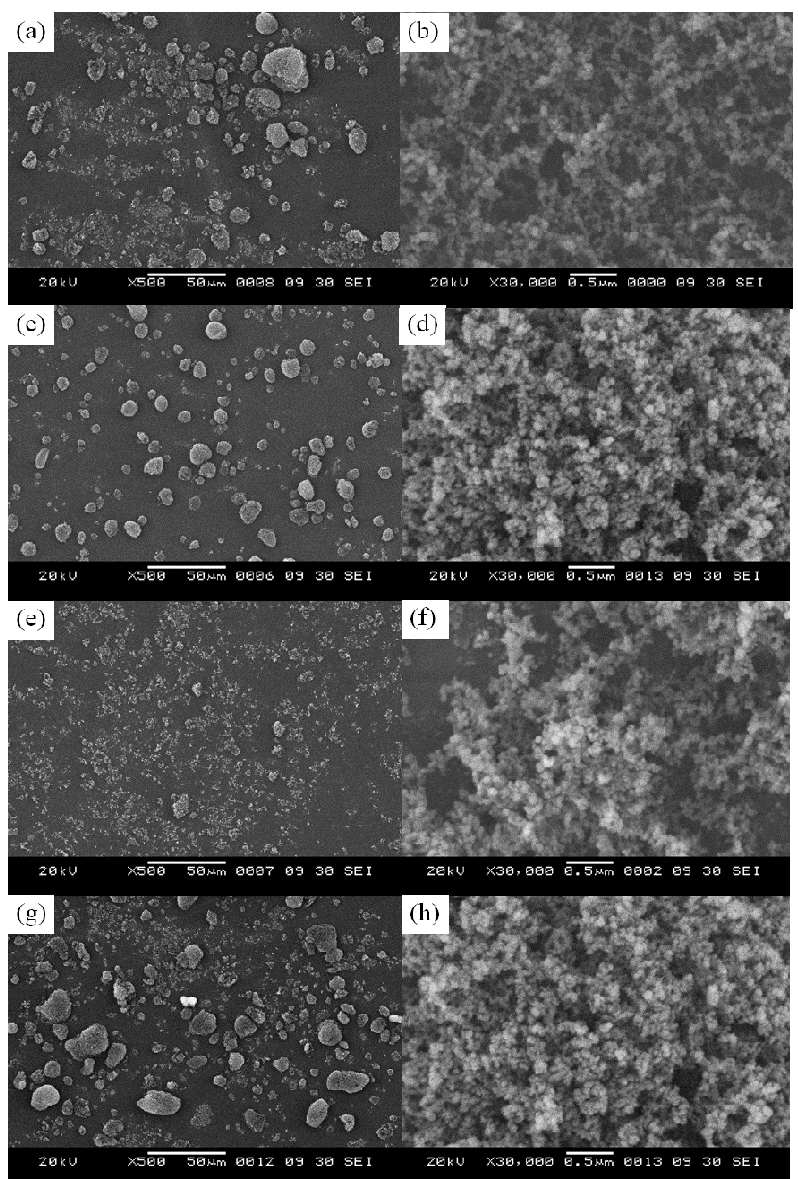
Figure 2. SEM images of different treated silicas; (a) NTS; (c) TSDMSF; (e) TSDMDCS; (g) TSHMDS; and (b) , (d) , (f) , and (h) represent the primary particles of corresponding treated silicas,